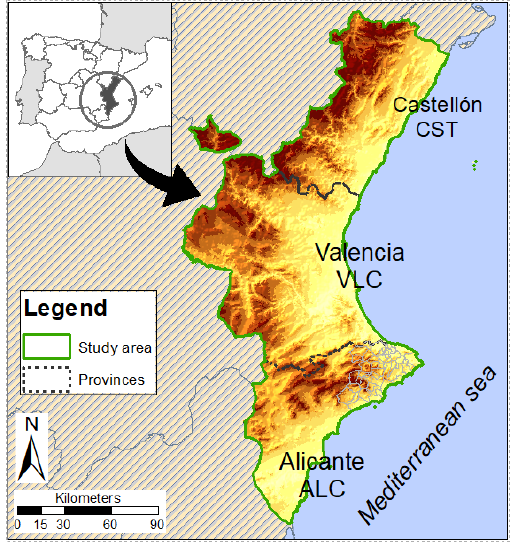
Figure 1. Situation and distribution map of provinces in the Region of Valencia (Spain).